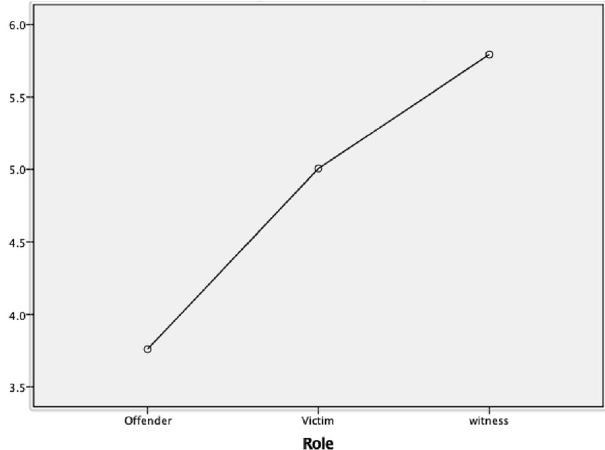
Fig. 5 Mean severity ratings divided in the offenders, victims and witnesses. The fi gure shows the mean severity ratings for offenders, victims and